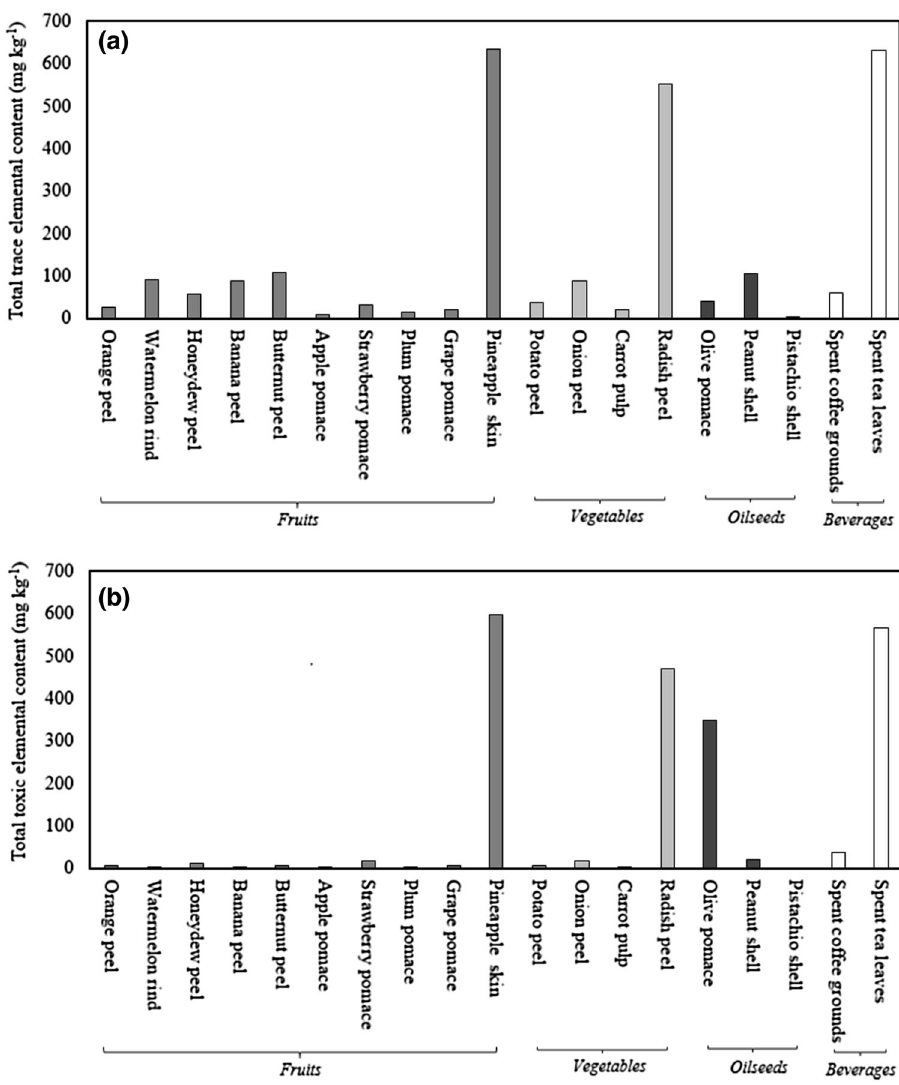
Fig. 2 Concentration of total trace ( a ) and toxic ( b ) elements (dry weight basis) in